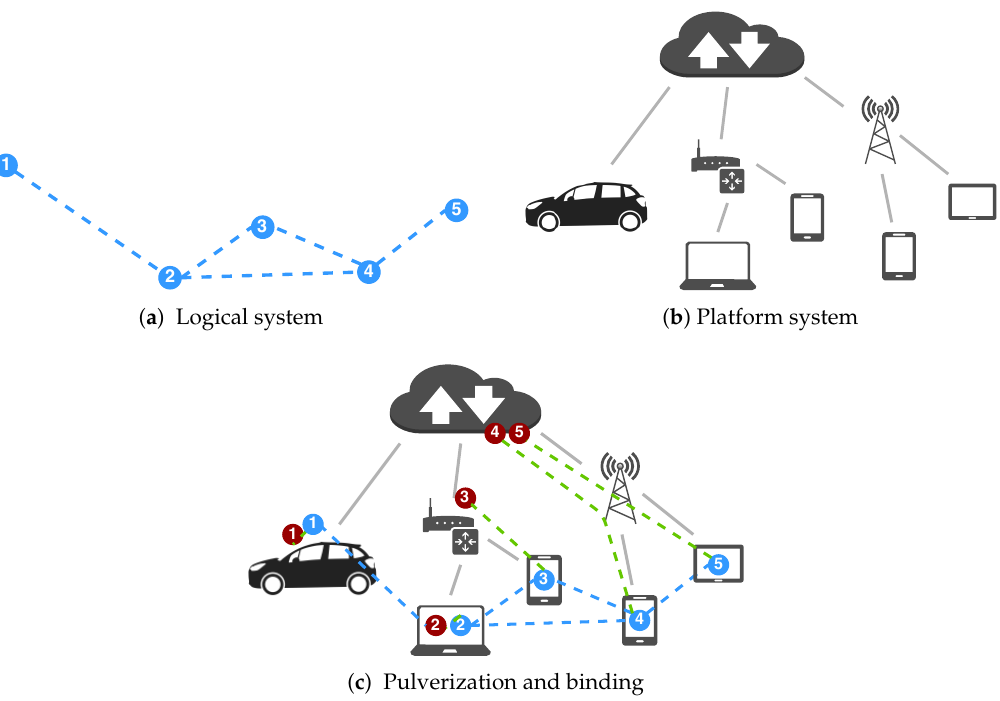
Figure 1. Deployment independence via pulverization. Designers of the business logic target the logical system ( a ), whose abstractions are identifiable nodes and neighbors. Once the deployment target (composed of hosts and communication channels) is identified ( b ), logical devices are pulverized into sub-components, which are then mapped to hosts ( c ). In the latter figure, green dashed lines represent network interactions between single-device